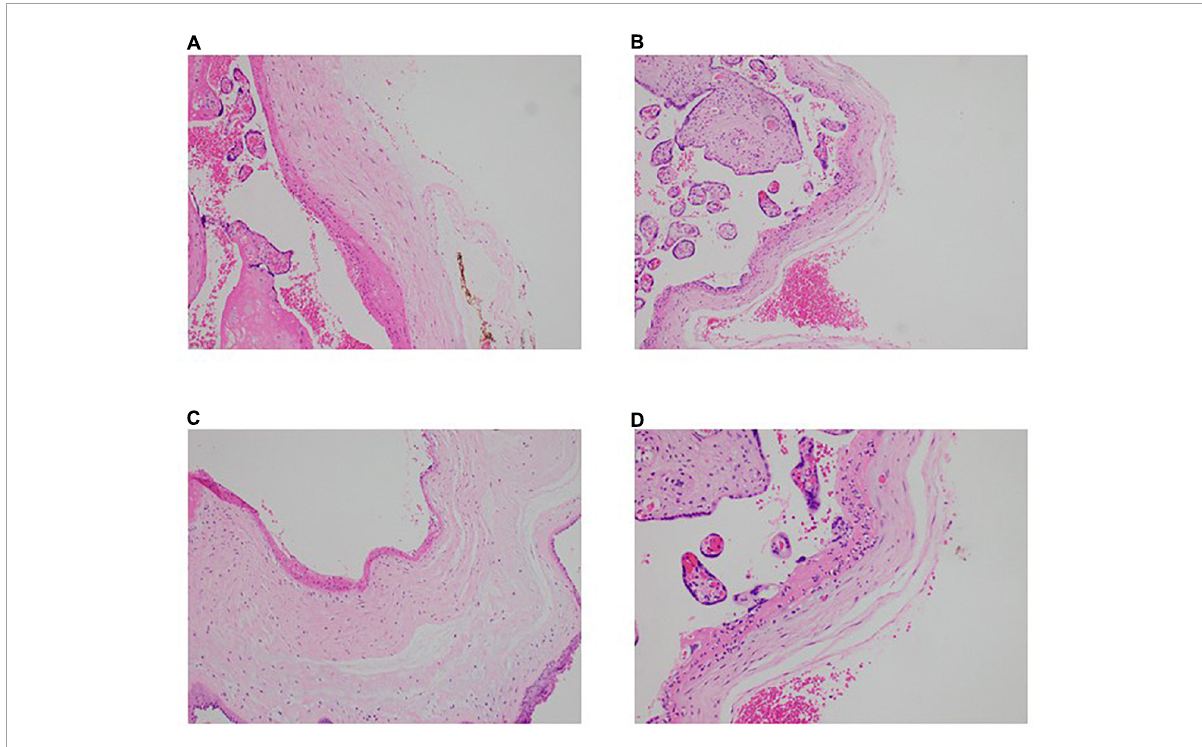
FIGURE1 Neutrophilic infiltration present in the placentae of convalescent mothers. Microscopic analysis shows a neutrophilic infiltrate in the subchorionic region of the placentae of three patients— (A) patient CS2, H&E × 100, (B) patient CS3, H&E × 100, (C) patient CS7, H&E × 100. (D) Higher power view of the inflammatory process (patient CS3, H&E ×